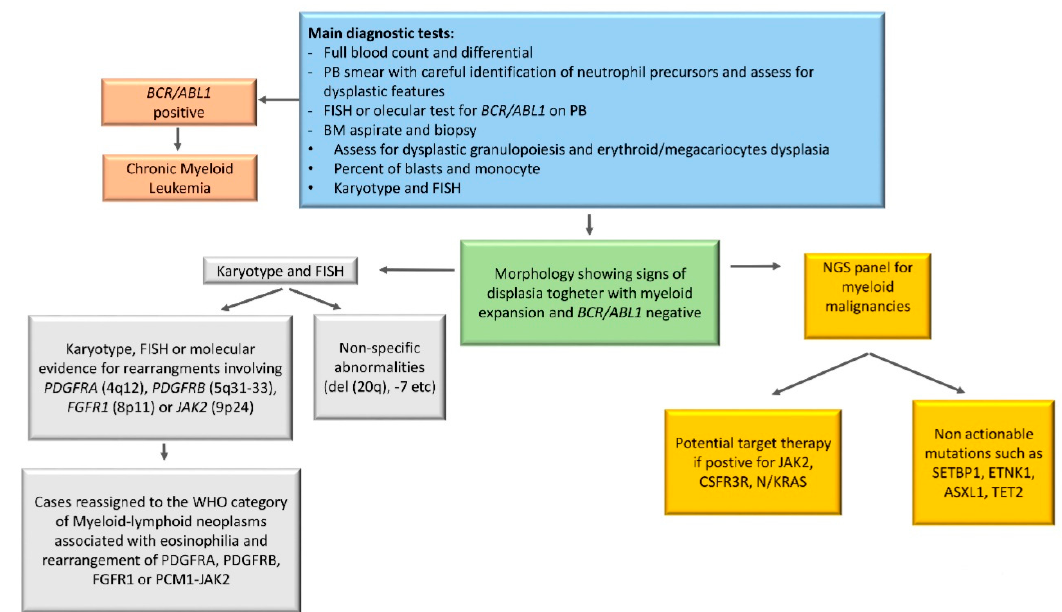
Figure 2. Diagnostic algorithm for aCML. The diagnostic work up should start with complete blood count with manual differential, morphological examination of PB smear, BM examination with assessment of dysplastic features, cytogenetic analysis, and fluorescence in situ hybridization (FISH) to exclude Ph + chromosome and rearrangements involving PDGFRA (4q12), PDGFRB (5q31–33), FGFR1 (8p11), or JAK2 (9p24). Second level testing should include NGS with a myeloid panel, not only to confirm diagnosis but also to open the possibility of identifying druggable targets. PB,